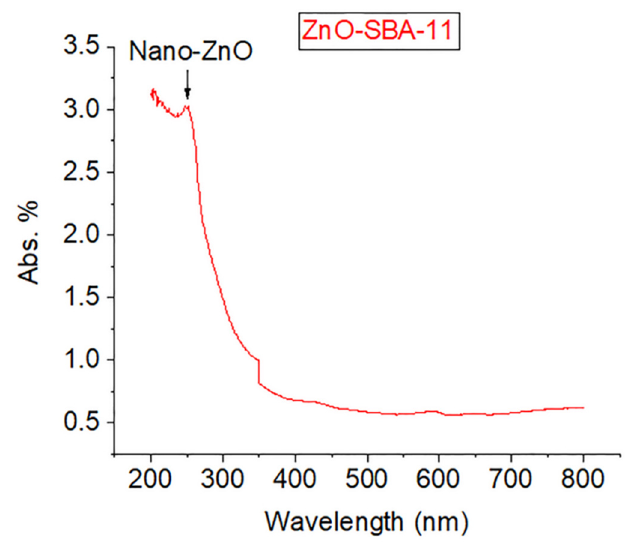
Figure 5. UV–VIS spectroscopy of ZnO-SBA-11 in the solid state.